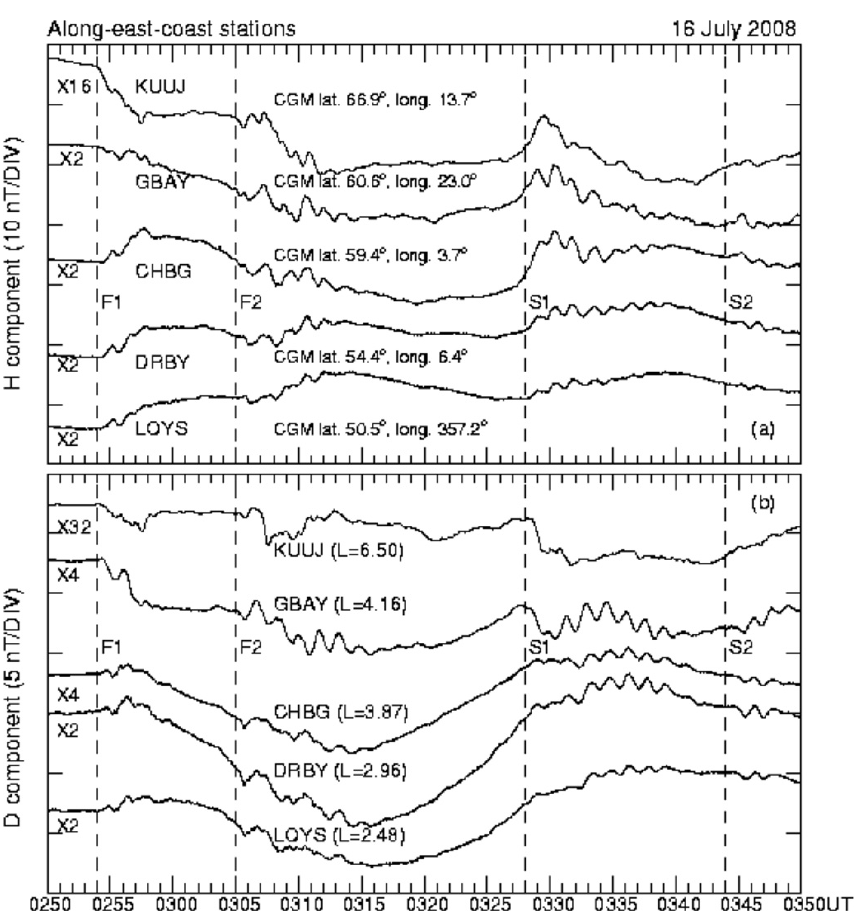
Fig. 2. The H- and D-components at the ground stations along the East Coast of North America from 02:50UT to 03:50UT on 16 July 2008. The vertical dashed lines denote ground Pi2 onsets. The letter F denotes the first substorm and the letter S denotes the second one. For each substorm, two consecutive Pi2 onsets are marked with a serial number,